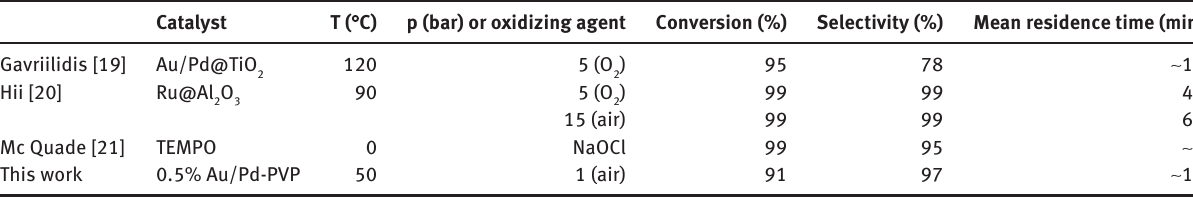
Table 3 Oxidation of benzyl alcohol to benzaldehyde in microfluidic